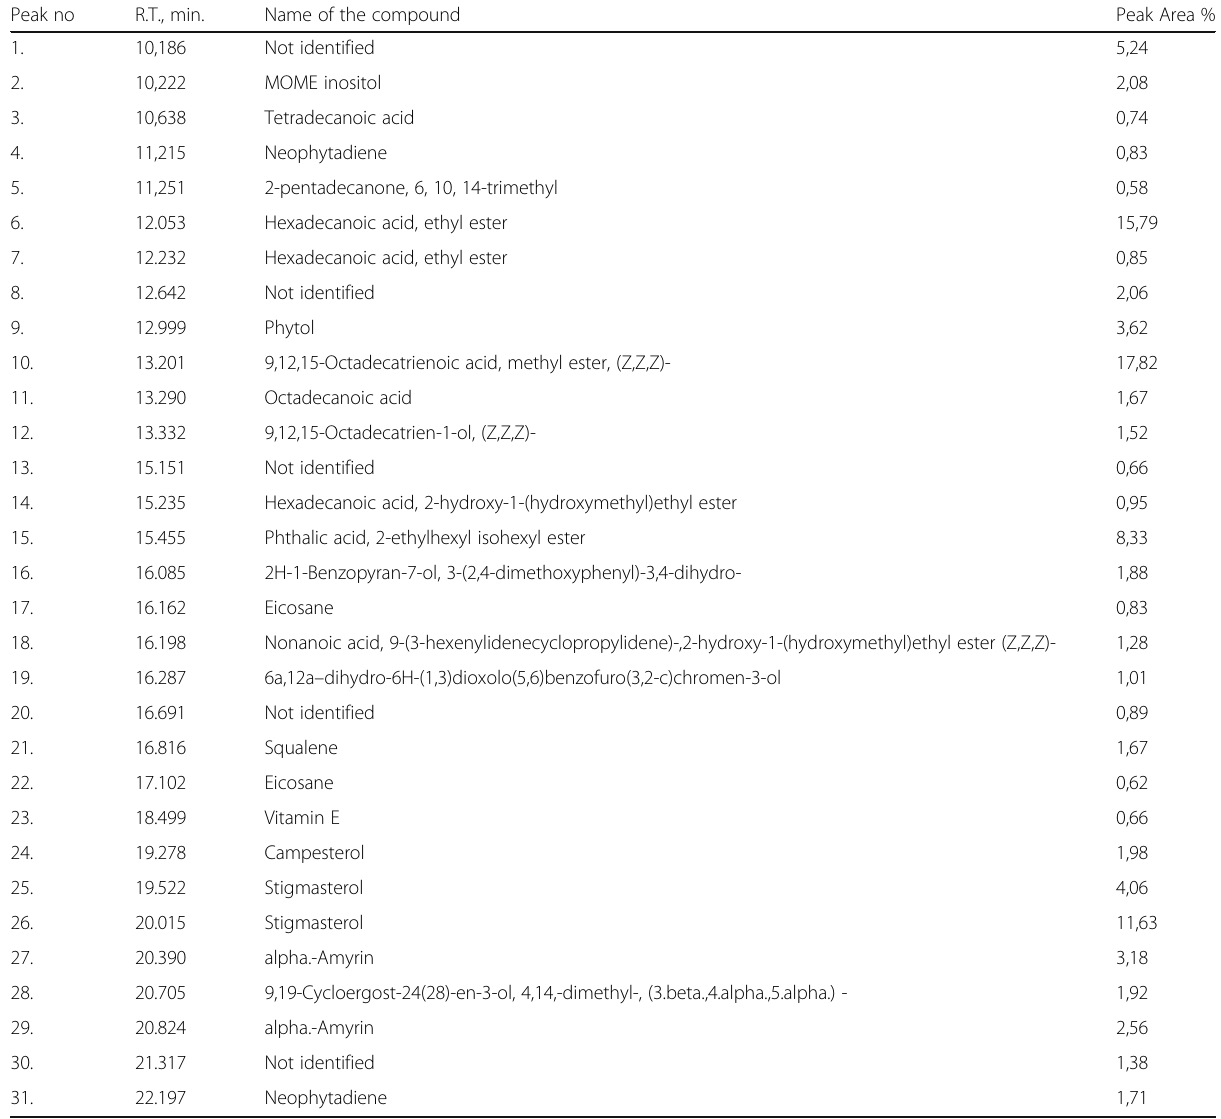
Table 1 Qualitative and quantitative analysis of biologically active substances in chloroform fraction of Galega officinalis extract Peak no R.T.,